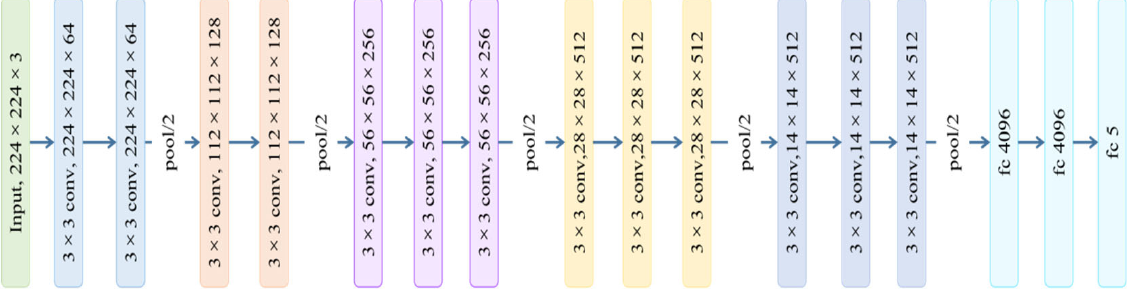
Figure 4. VGG16 model structure diagram. conv stands for convolutional layer. fc stands for fully connected layer.